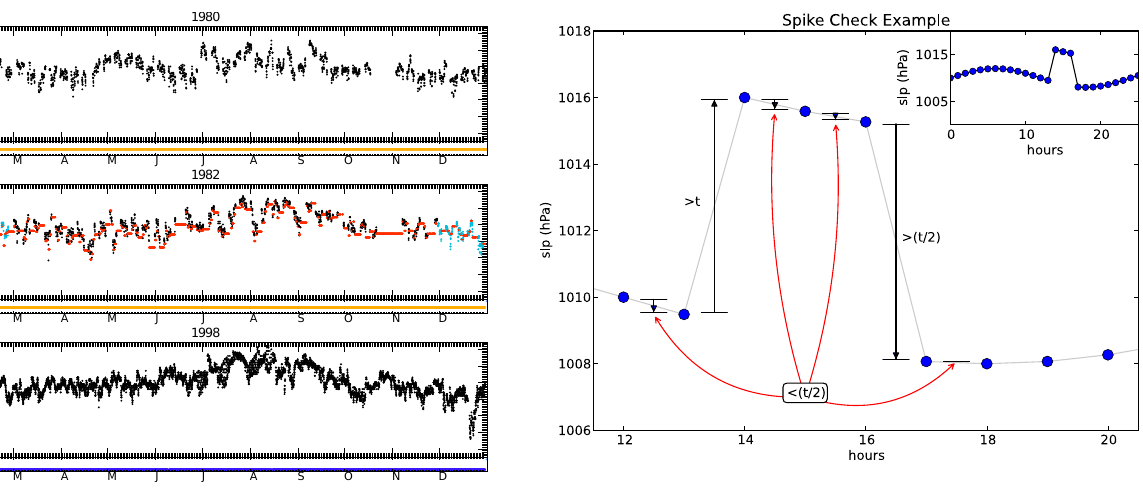
Fig. 9. Repeated streaks/unusual streak frequency check (test 8) example for composite station 724797-23176 (Milford, UT, USA; 38.44 ◦ N, 112.038 ◦ W, 1534m), for dewpoint temperature in 1982, illustrating frequent short streaks. Red points show values removed by this test and blue points by other tests. The panel below each year shows whether the data in the composited station come from the named station (blue) or a matched station (orange). There is no change in source station in 1982, and so the compositing has not caused the streaks observed in 1982, but a different station is used in 1998 compared to the other two years.